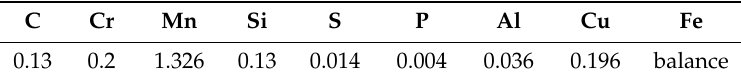
Table 12. Chemical composition of DP 980 dual phase stainless steel